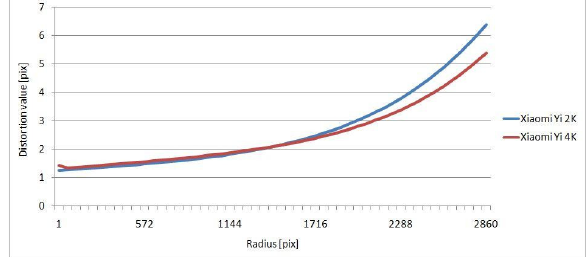
Figure 5. Comparison of distortion values for Xiaomi cameras (red - 4K, blue -2k)